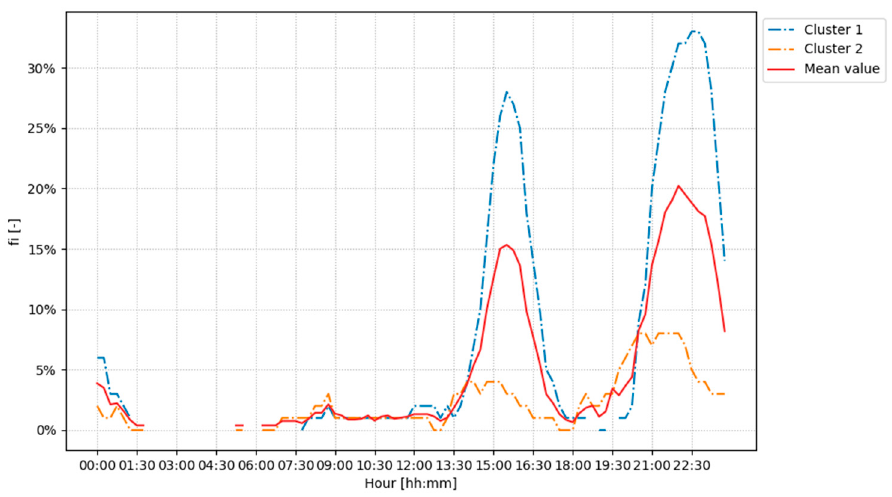
Figure 9. Daily usage probability: Dishwashers.